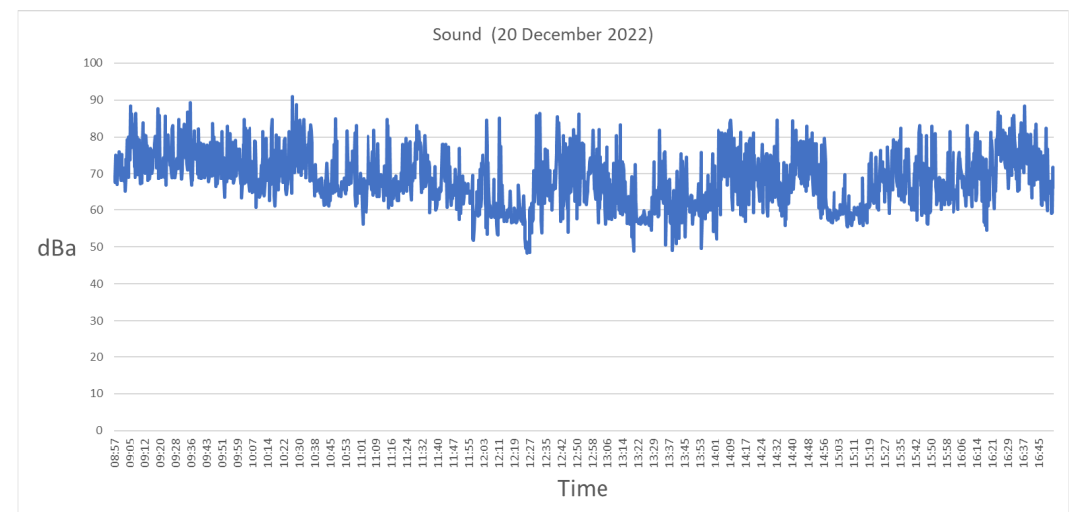
Figure 24. One day sound level inside a classroom.